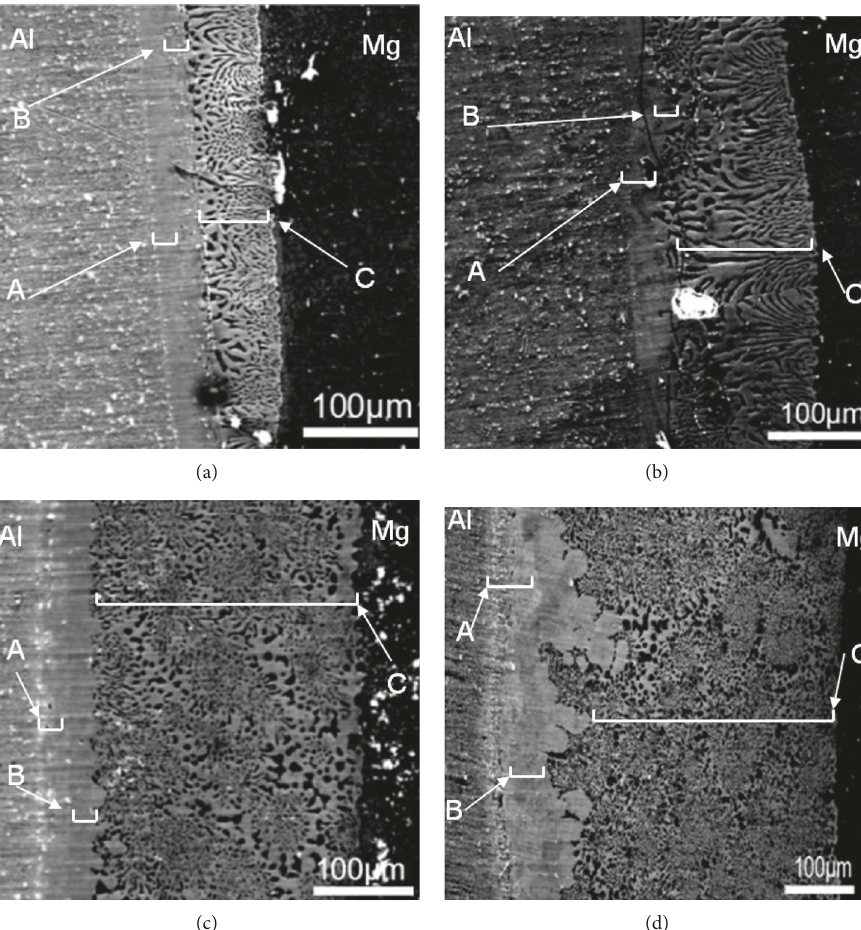
Figure 8: SEM micrographs of joints: (a) without annealing and annealing at (b) 200 ° C, (c) 250 ° C, and (d) 300 ° C; layer A: Al layer B: Mg 17 Al 12 , and layer C: Mg-based solid